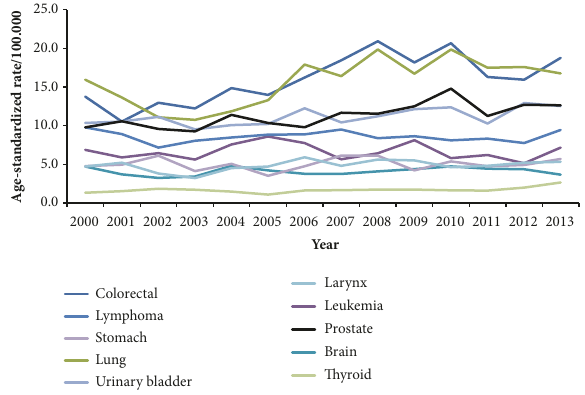
Figure 2: The trend in the age-standardized incidence rates of top 10 cancers for males in Jordan, 2000-2013.